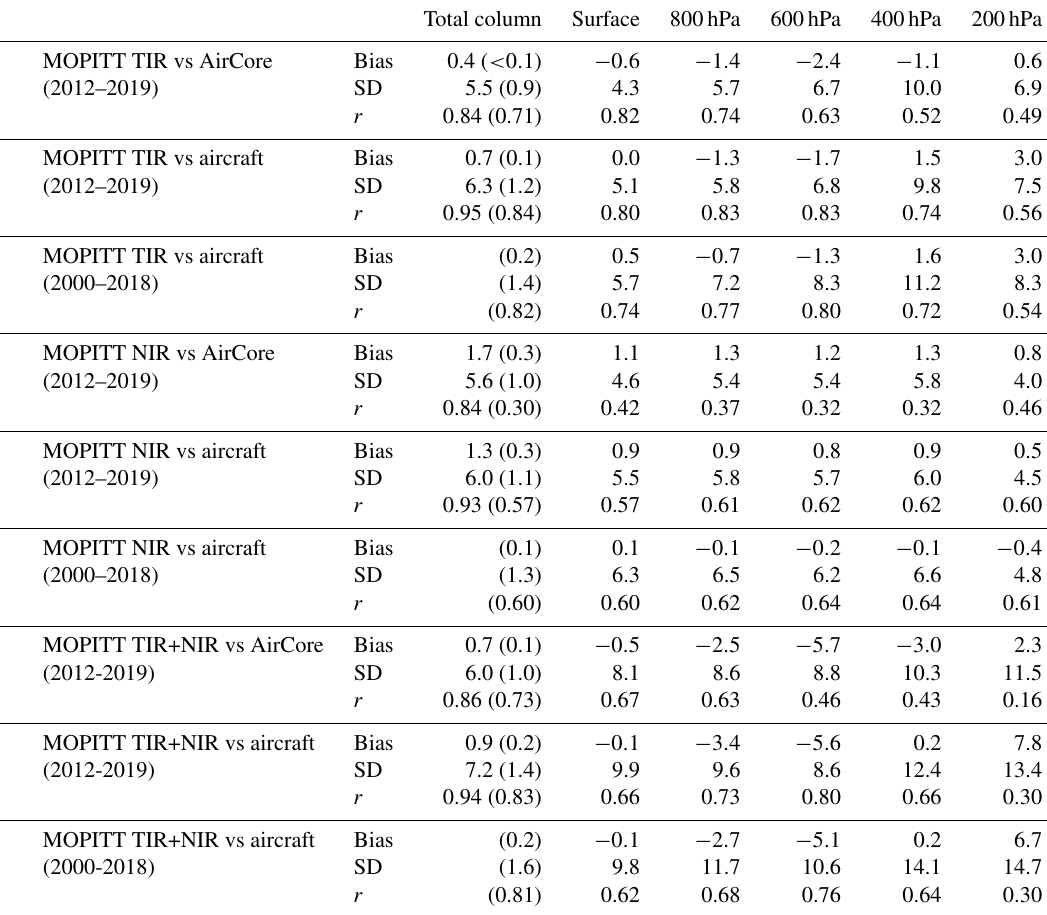
Table 1. Statistics from the comparison of MOPITT CO with respect to AirCore and to NOAA aircraft flask data for the 2012–2019 period. Statistics from the validation of MOPITT CO with respect to aircraft data for 2000–2018 (Deeter et al., 2019) are also included for reference. Column bias and SD are provided in percent (%) and in units of 10 17 molec.cm − 2 (in parentheses). Column bias r from VMR values (in parentheses) are lower than r from percent values because VMR results are presented in terms of log(VMR) after subtracting the a priori values (see Deeter et al., 2017); thus, the a priori variability does not contribute to the correlation. Partial column relative bias and SD in %. Partial column results only shown for even pressure levels, for